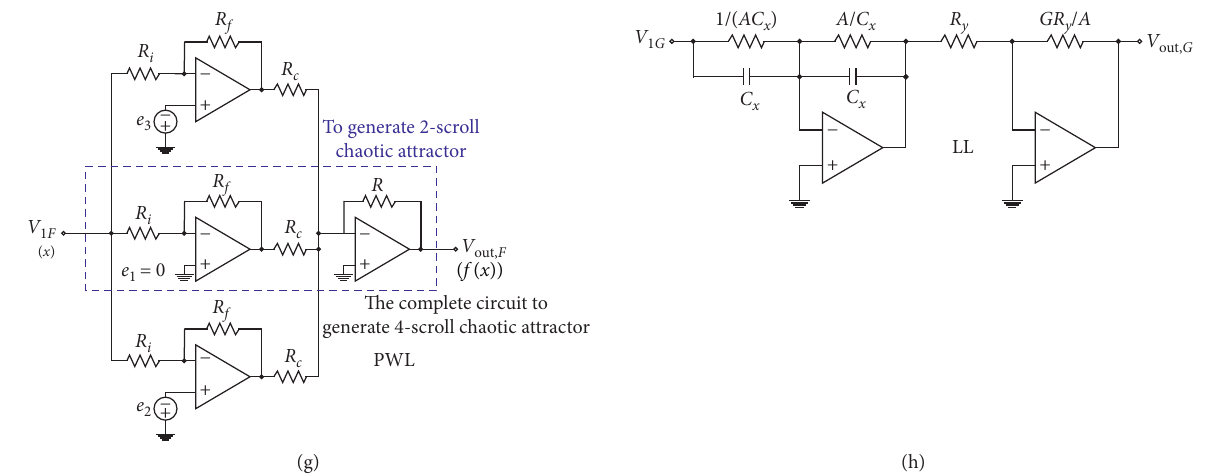
Figure 2: Basic building blocks. (a) Weighted differential amplifier (WDA). (b) Two-input weighted adder amplifier (WAA). (c) Inverting integrator (IInv). (d) Inverting amplifier (Inv). (e) Four-input inverting weighted adder amplifier (IWAA). (f) SNLF for generating two and four scrolls. (g) Circuit realization of SNLF to generate two and four scrolls. (h) Lead/lag phase